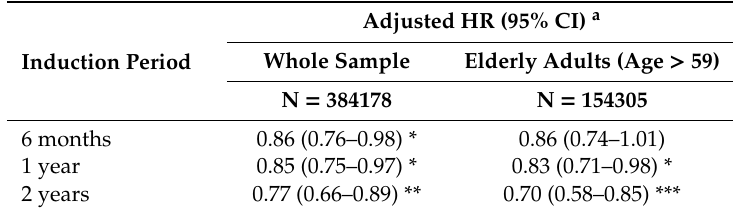
Table 2. Sensitivity analysis for SSRI use and bladder cancer incidence in di ff erent induction periods after propensity score